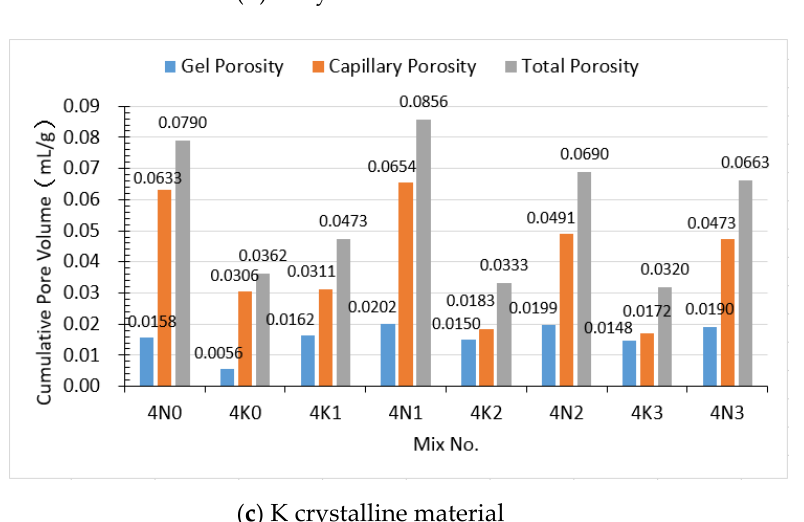
Figure 14. Pore relationships of cement mortar when W/C = 0.4 after 56-day curing.